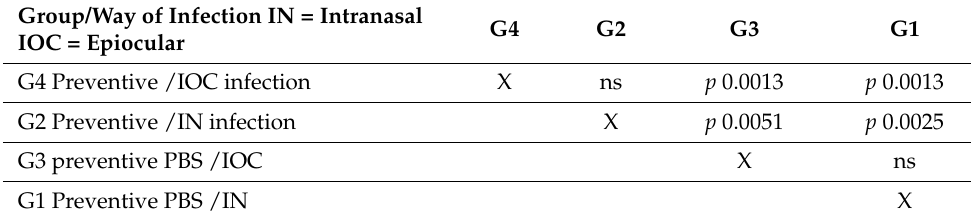
Figure 5. SARS-CoV-2-neutralising antibodies in the serum of the different groups of hamsters. The Y scale is in dilutions of serum resulting in a 50% mortality of the VeroE6 cells as described above. There is evidence of high antibody levels in the two previously infected and healed groups G2 and G4. Table 2. This table shows that the 2 times exposure format in the healed groups lead to significantly higher neutralizing antibody titres than the disease alone. An asymptomatic re-exposure to the virus triggers a high antibody level in the blood. Interestingly, the intranasal PBS before IN virus exposure resulted in less antibody production possibly as result of severe disease. Students t -test p: level of significance, ns: not